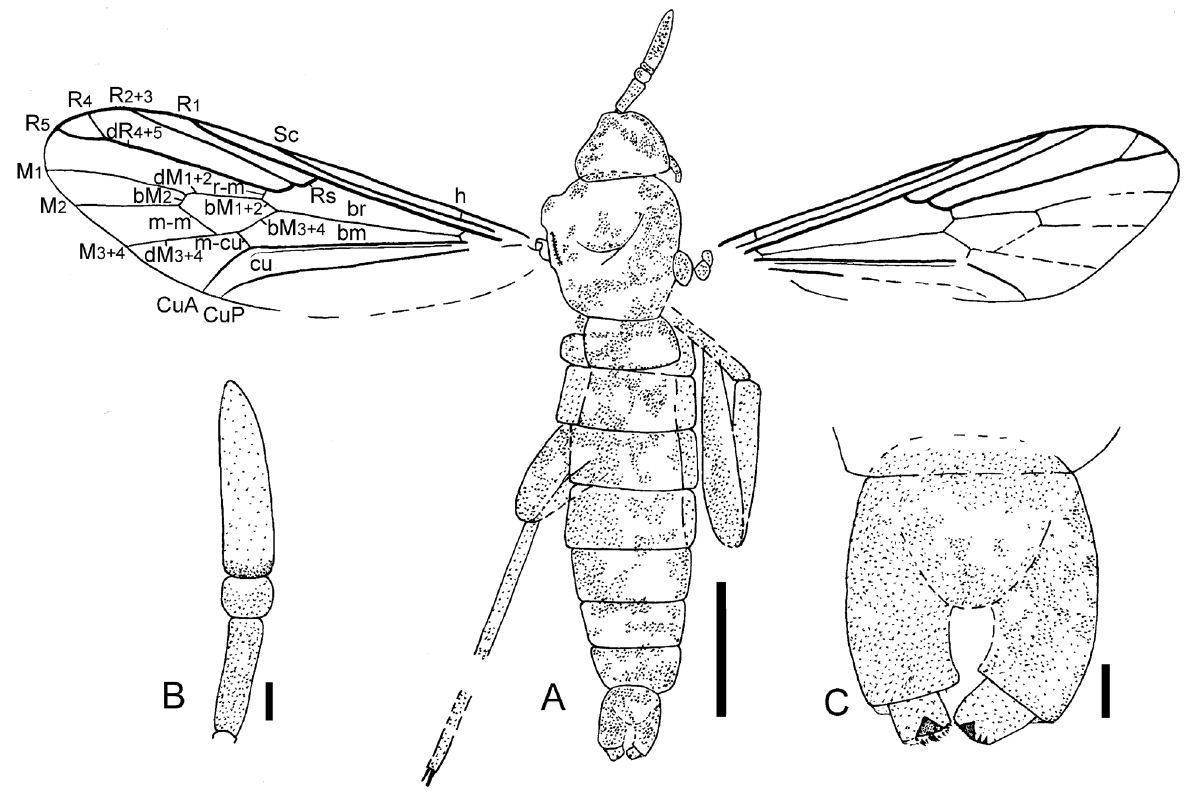
Figure 2. Flagellisargus ( Changbingisargus ) parvus subgen. et sp. n. line drawings of holotype NIGP DHG01701, A habitus (dorsal view), B antenna, C male genitalia. Scale bar 1 mm ( A ) 0.1 mm, ( B, C ).